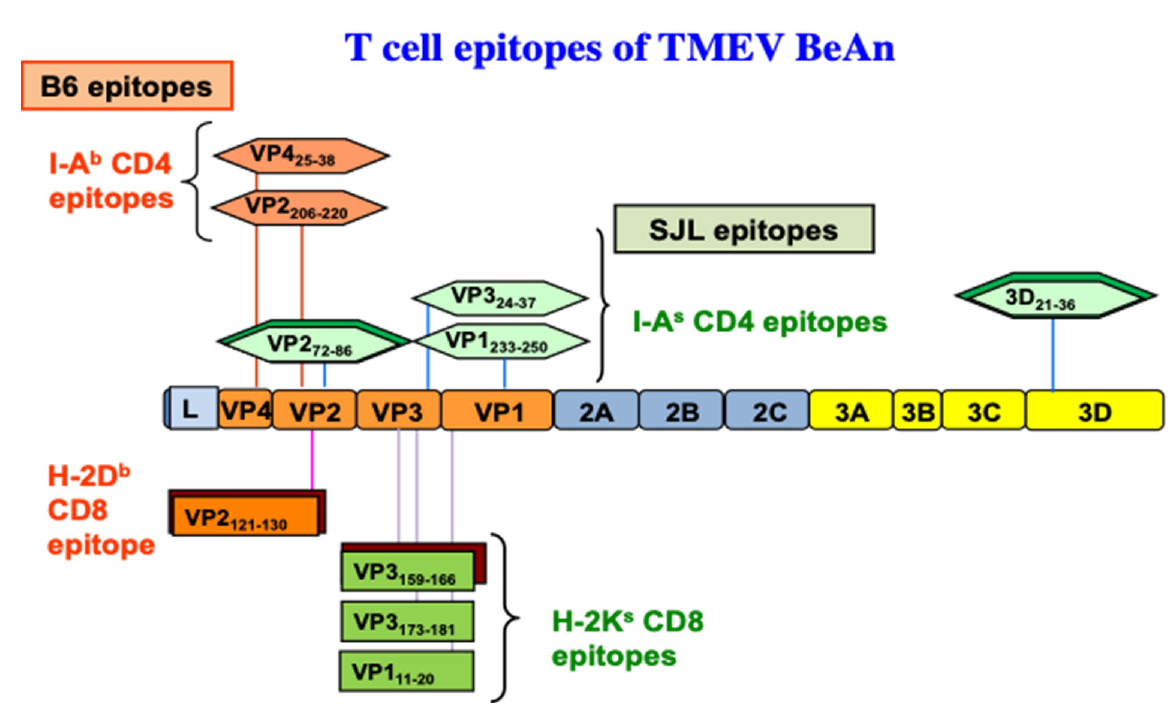
Figure 3. CD4 + and CD8 + T cell epitopes of the BeAn strain of TMEV restricted with MHC H-2 b and H-2 s haplotypes. The predominant epitopes are indicated by double boxes. One predominant H-2D b -restricted CD8 T cell epitope [135] and one predominant and two subdominant epitopes were found to be restricted with H-2K s [35].